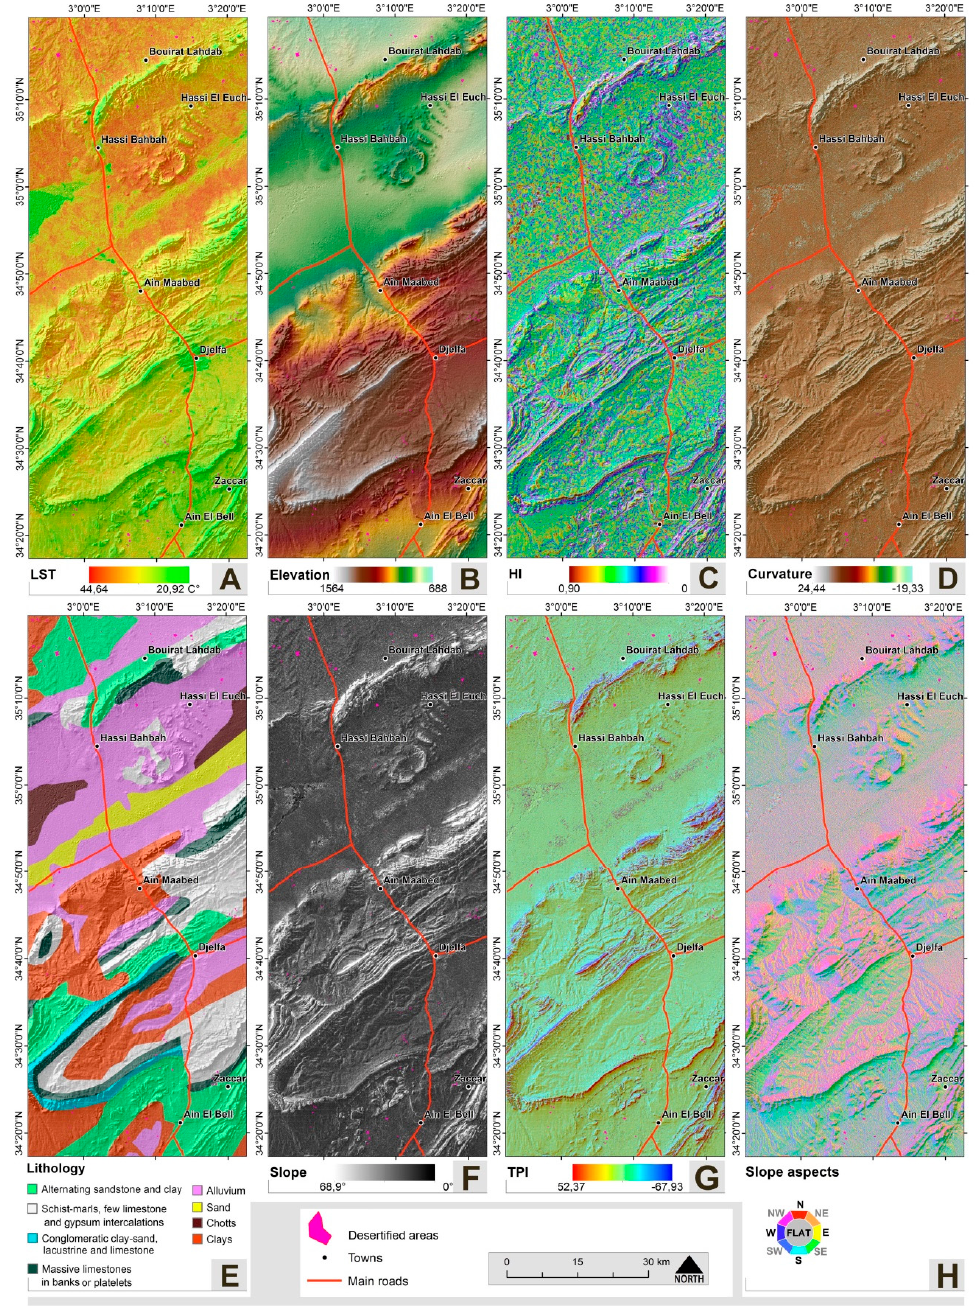
Figure 3 . Maps of the geomorphological and soil prediction factors: ( A ) land surface temperature (LST); ( B ) elevation; ( C ) hypsometric integral (HI); ( D ) curvature; ( E ) lithology; ( F ) slope; ( G ) topographic position index (TPI); and ( H ) aspect. For the slope aspect, the percentages of desertified areas for the six faces—west, northwest, north, northeast, east, and southeast—ranged between 10.17% and 12.18%, and increased to more than 14% for the south or southwest faces. The flat face had the lowest percentage of desertified areas, at 2.90% (Figure 3H).